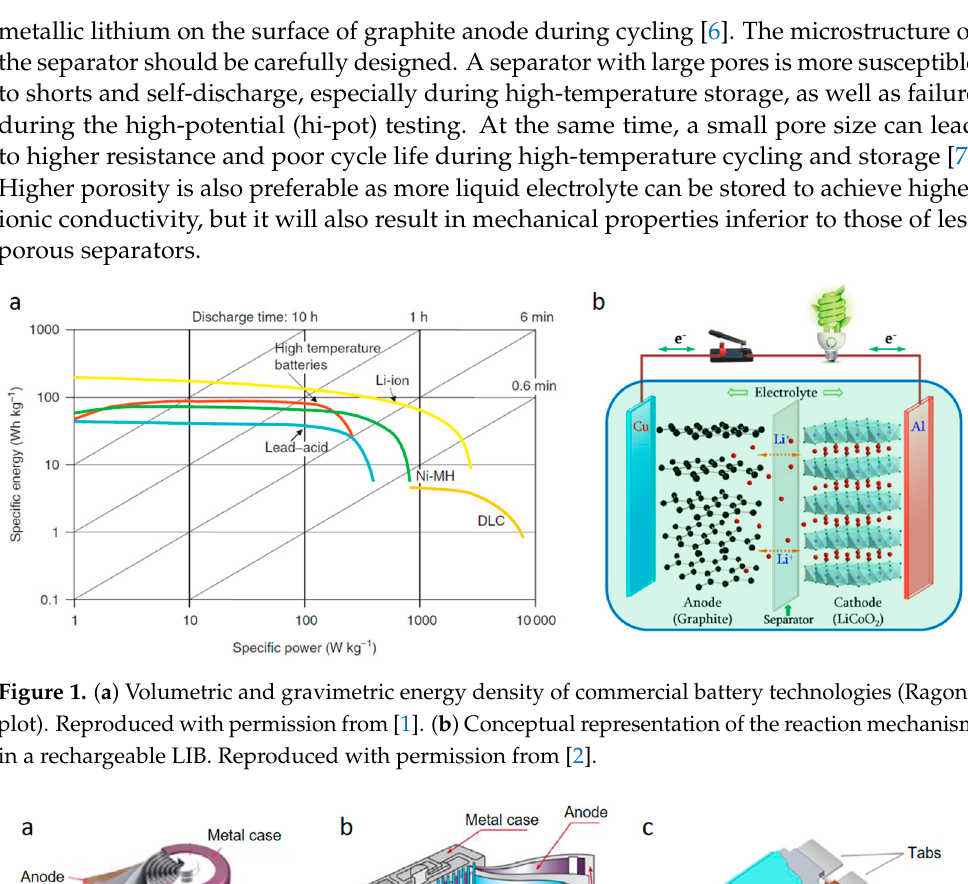
Figure 1. ( a ) Volumetric and gravimetric energy density of commercial battery technologies (Ragone plot). Reproduced with permission from [1]. ( b ) Conceptual representation of the reaction mechanism in a rechargeable LIB. Reproduced with permission from [2].